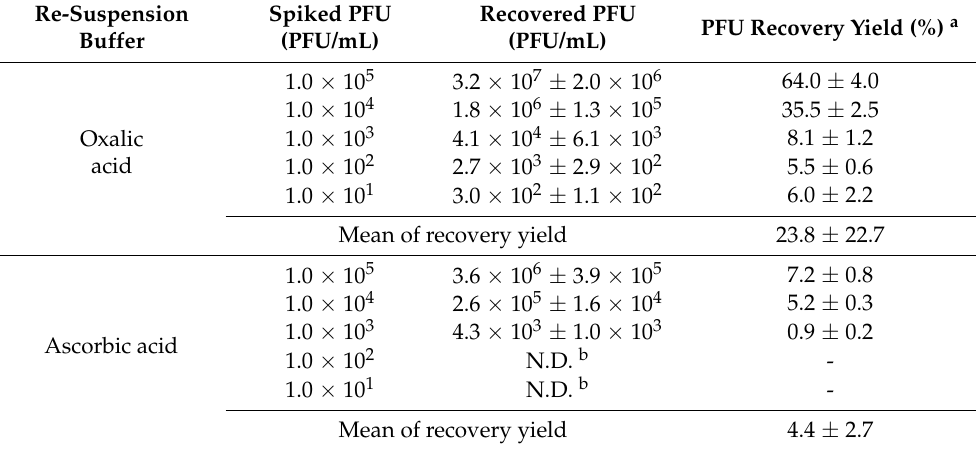
Table 3. VHSV infective particle recovery yield from artificial virus-spiked seawater by plaque